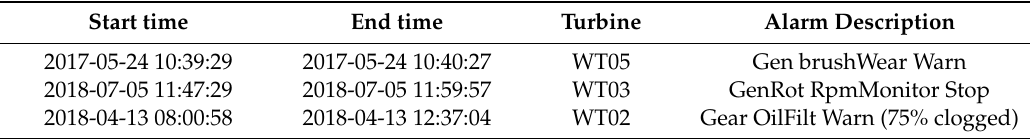
Table 2. Alarm dataset sample.